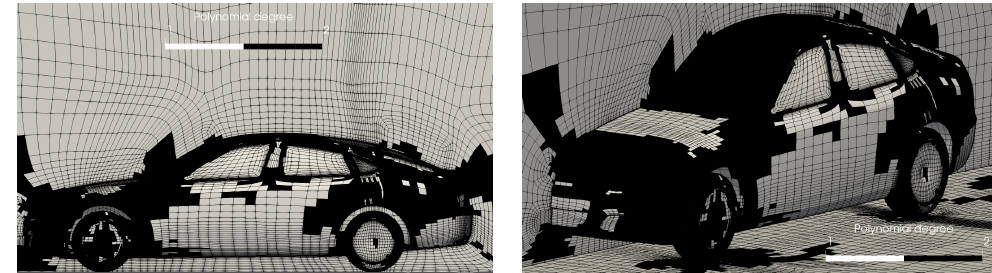
Figure 14. DrivAer model—Polynomial degree distribution P n of the solution from the lateral ( left ) and the front ( right ) point of